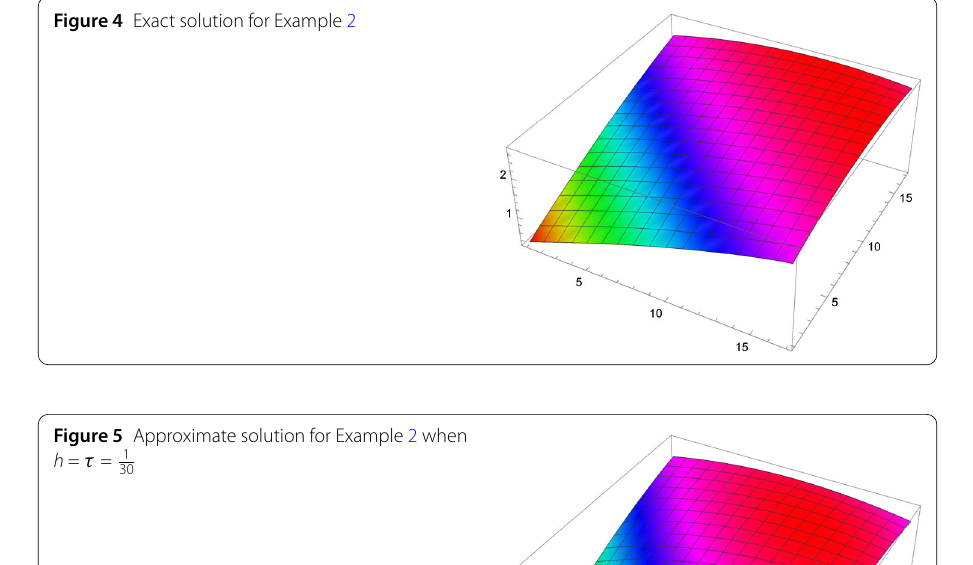
Figure 4 Exact solution for Example 2